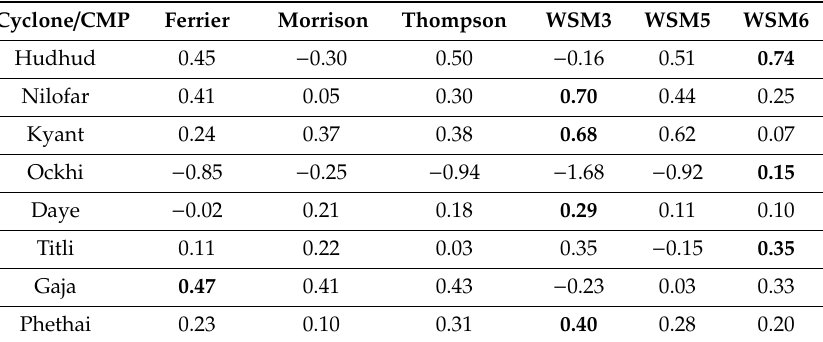
Table 6. Skill score for mean sea level pressure